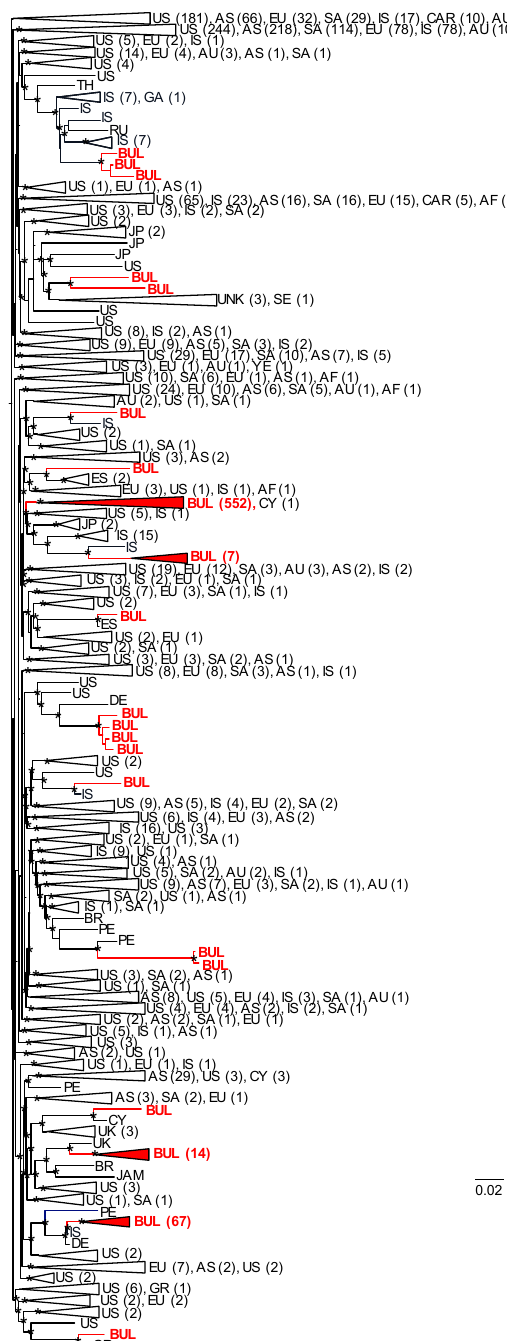
Figure 3. Maximum-likelihood (ML) phylogeny of global HIV-1 subtype B sequences. The ML tree was constructed with FastTree v2.1.10 using 663 sequences from Bulgaria and 1933 global sequences. Confidence values of clusters were assessed by using the Shimodaira–Hasegawa (SH) test in FastTree. SH values > 0.7 are shown at nodes with an asterisk. Large clades are collapsed, and the corresponding country or continent are provided with codes followed by total numbers of sequences in parentheses. AF, Africa; AS, Asia; AU, Australia; BR, Brazil; BUL, Bulgaria (in red text); CA, Canada; CAR, Caribbean; CR, Costa Rica; CU, Cuba; CY, Cyprus; DE, Germany; ES, Spain; EU Europe; GA, Georgia; GR, Greece; IS, Israel; JAM, Jamaica; JP, Japan; PE, Peru; SA, South America; SE, Sweden; RU, Russia; TH, Thailand; UKR, Ukraine; UK, United Kingdom; UNK, unknown; US, United States; YE,